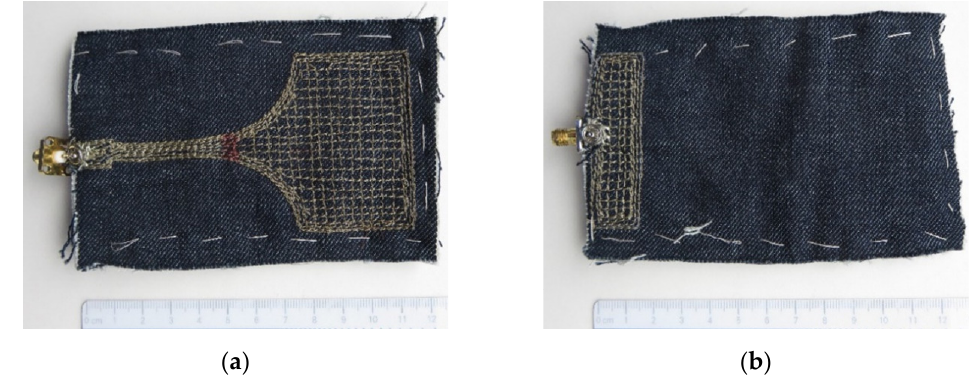
Figure 4. Wideband textile planar monopole: ( a ) radiating element and ( b ) ground